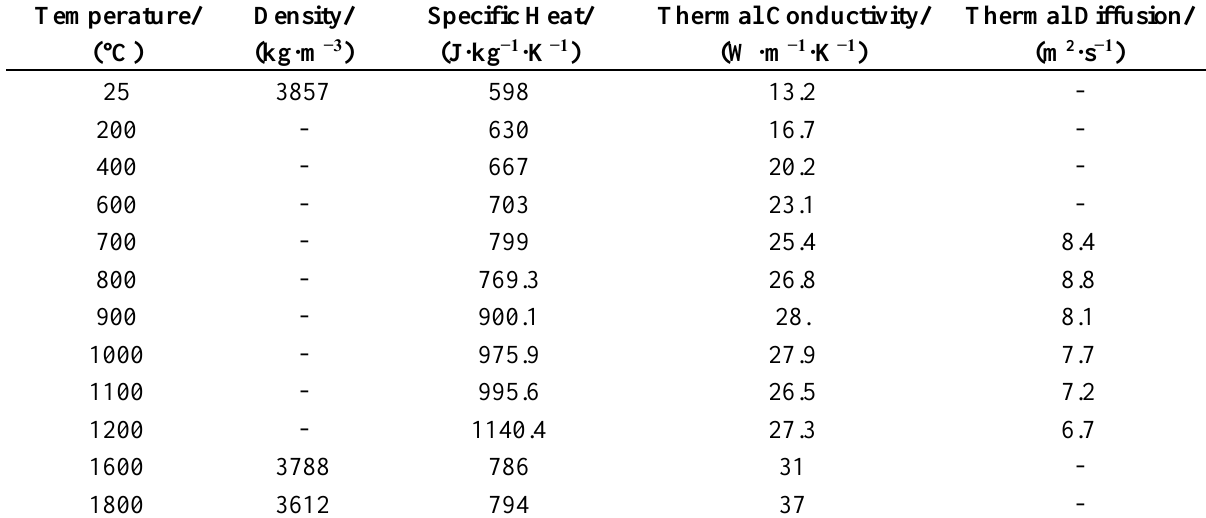
Table 1. Thermo-physical properties of TiAl alloy varied with temperature.